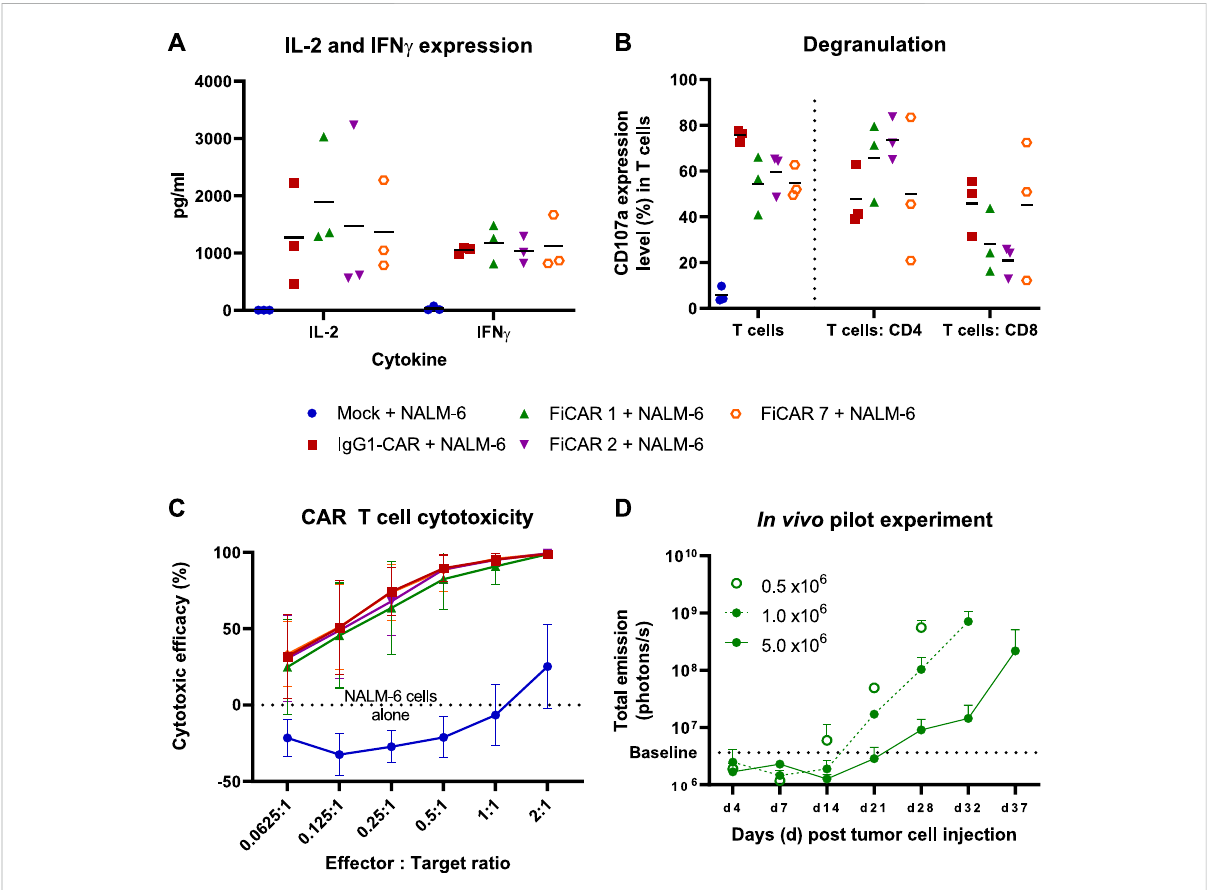
FIGURE 3 T cell responses and cytotoxicity against CD19 positive NALM-6 cells. The mean (black horizontal lines) and individual data points are shown [Figures (A,B) ; n = 3] (A) CAR T cells were co-cultured with NALM-6 cells at 1:1 E:T ratio for 18 h after which the cytokines were analyzed from co- culture supernatants. (B) Degranulationof Tcellsin response toCD19positive NALM -6 cellswas analyzed bystaining theCD107a inTcells after 4 h co-culture inthepresence on GolgiStop proteintransportinhibitor. The results show the percentage ofCD107a expressing cells of totalTcells and of the CD4 and CD8 subpopulations. (C) In vitro cytotoxicity of CAR T cells against luciferase expressing CD19 + NALM -6 cells at various E:T ratios. The mean±SD is shown. (D) In vivo pilot experiment. 0.5 x 10 6 Luc + NALM -6 cells were engrafted via tail vein into NSG mice ( n = 2 per group) on day 0. The indicated number of CAR T cells were injected on day 7. The mice were imaged between days 4-37 and the total emission from luciferase expressing CD19 + NALM -6 cells was measured. The values present mean